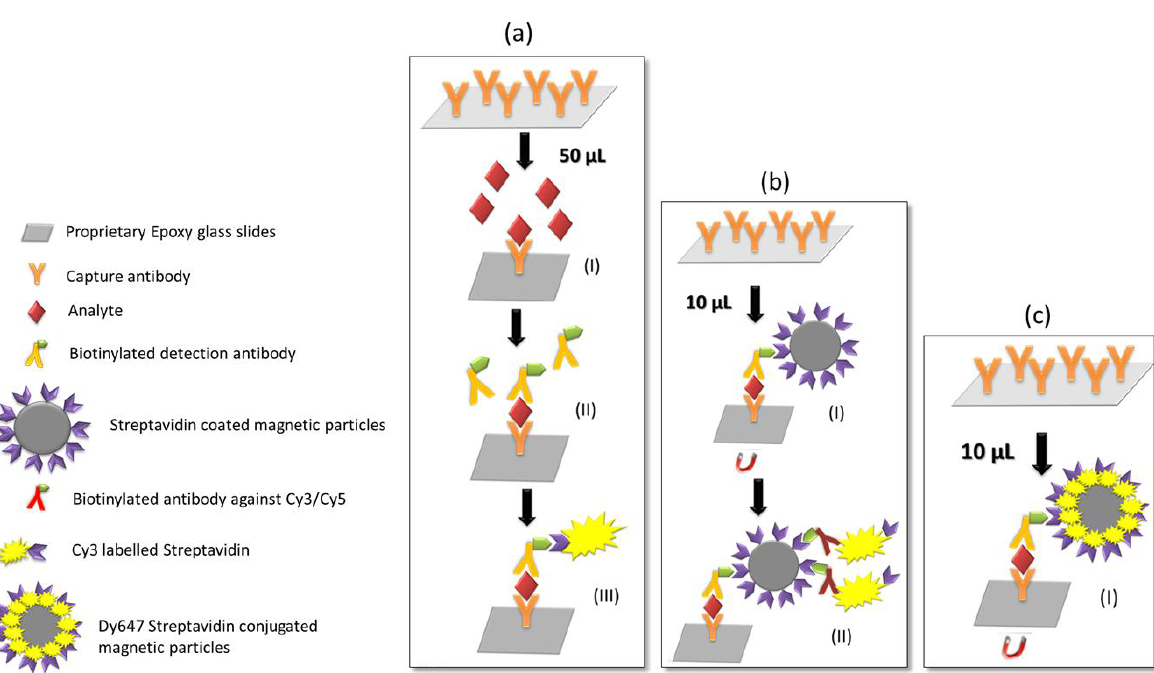
Figure 1. On-chip sandwich immunoassay steps for ( a ) the classical chip ( b ) the miniaturized chip and ( c ) the optimized miniaturized chip. Capture antibodies are immobilized equally providing same array format for the classical chip and the miniaturized chip. a(I) incubation of analytes (2.5 h), a(II) incubation of biotinylated detection antibodies (45 min), a(III) detection of bound antigens/antibodies via Dy647 Streptavidin incubation (45 min); b(I) Incubation of analytes, biotinylated antibodies and streptavidin conjugated magnetic particles in one step (2.5), b(II) detection via biotinylated antibody against Cy3/Cy5 and Cy3 labeled streptavidin; c(I) Incubation of analytes,